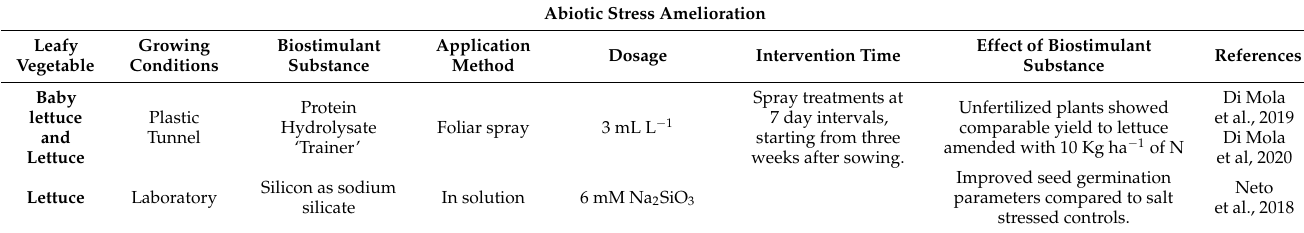
Table 2. An overview of the abiotic stress amelioration, growth improvement, and fruit quality enhancement by biostimulant substances on leafy vegetable